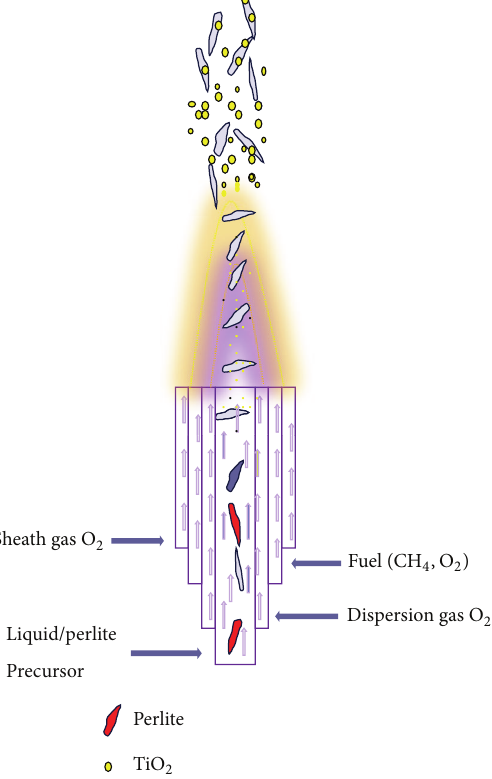
Figure 1: Schematic of the flame spray pyrolysis device. During spray procedure and after evaporation and combustion of precursor, TiO 2 nanoparticles are formed on perlite